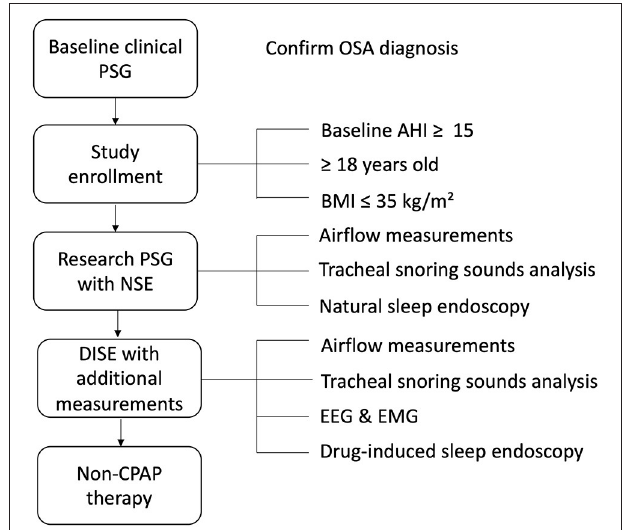
FIGURE 1 | Generic study protocol. AHI, apnea-hypopnea index; BMI, body mass index; CPAP, continuous positive airway pressure; DISE, drug-induced sleep endoscopy; EEG, electroencephalography; EMG, electromyography; NSE, natural sleep endoscopy; OSA, obstructive sleep apnea; PSG,